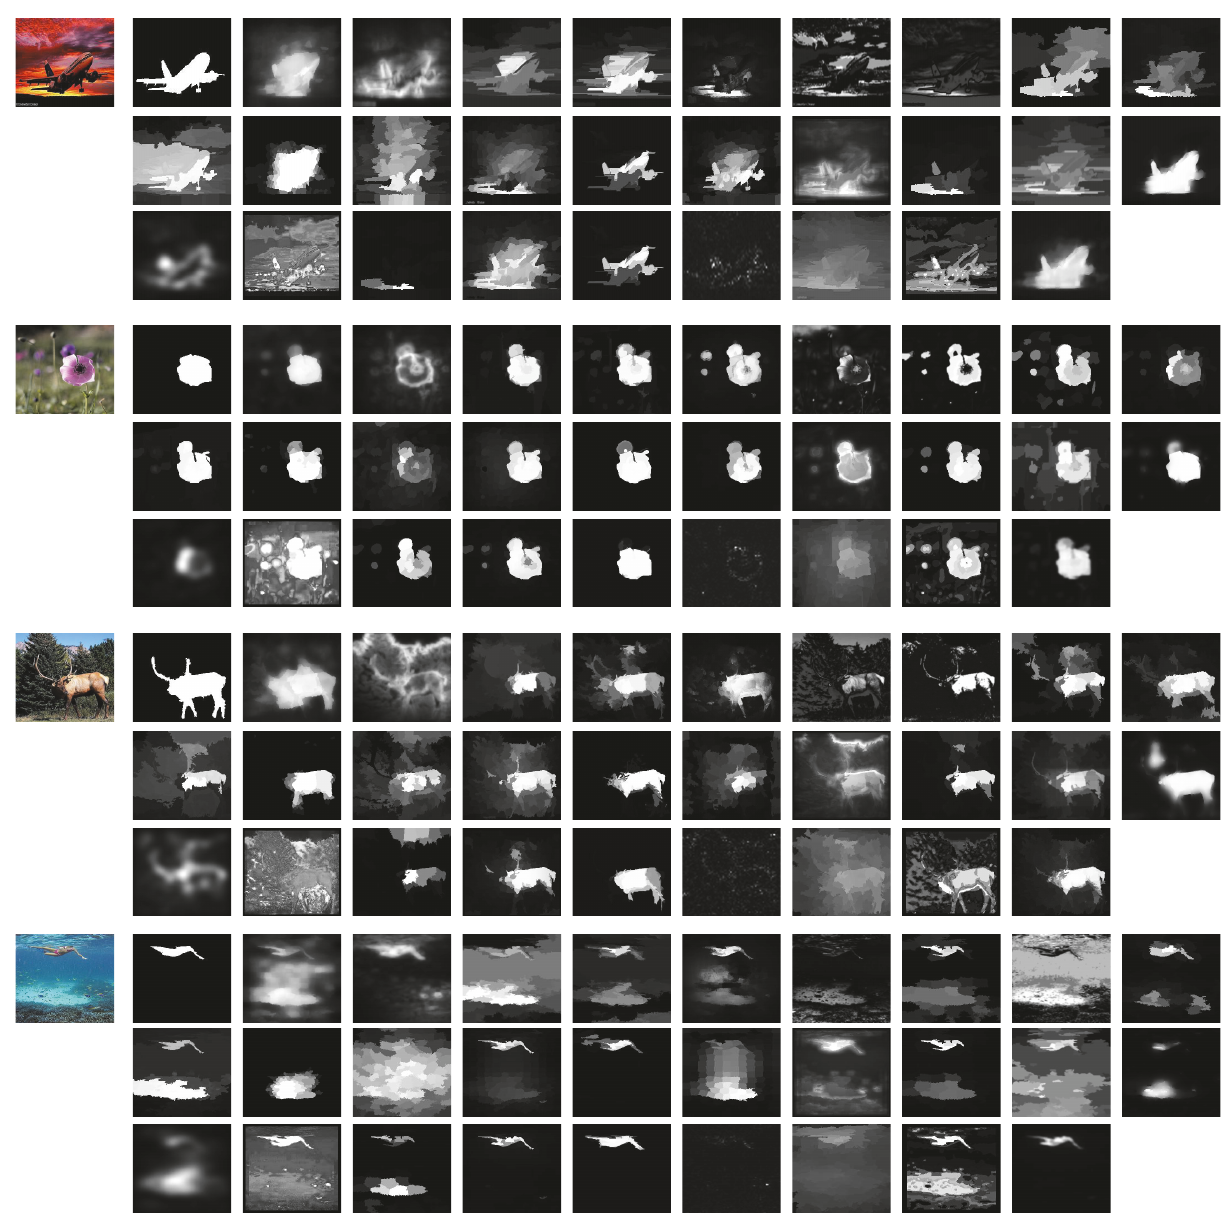
Figure 11: Visual comparisons of DBS with 27 state-of-the-art methods. The order of images are original image, ground truth mask, BL